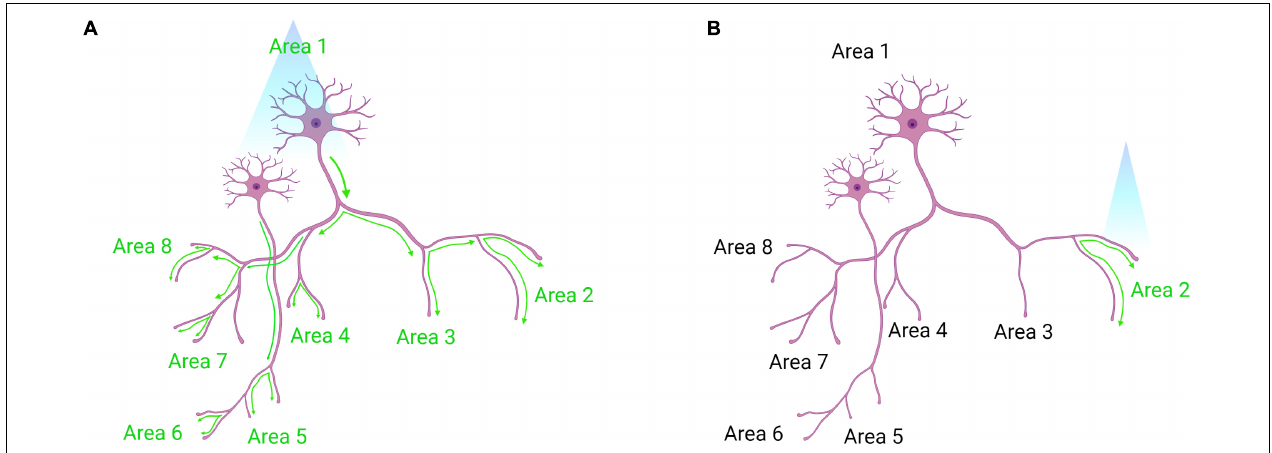
FIGURE 6 | Somatic optogenetic stimulation versus terminal field optogenetic stimulation. (A) Optogenetic stimulation of a population of neurons at their soma will lead to downstream activation of all the projection targets of that population (as indicated by green activation arrows). (B) Terminal field stimulation using optogenetics. Here, an investigator may be interested in the function of Area 1 neuron projections to Area 2 specifically. By placing the laser directly above Area 2, the investigator will activate only those projection terminals to dissect the neural circuit function more precisely. Created with